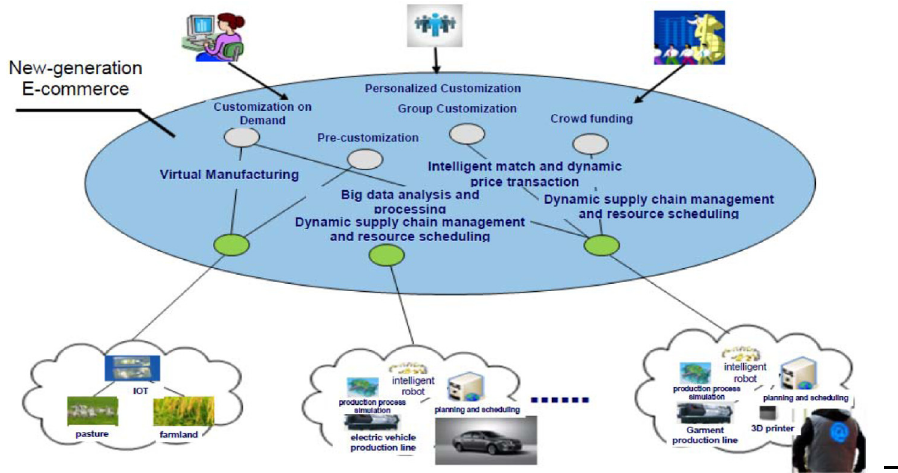
Figure 1. Future Web-based industrial operation